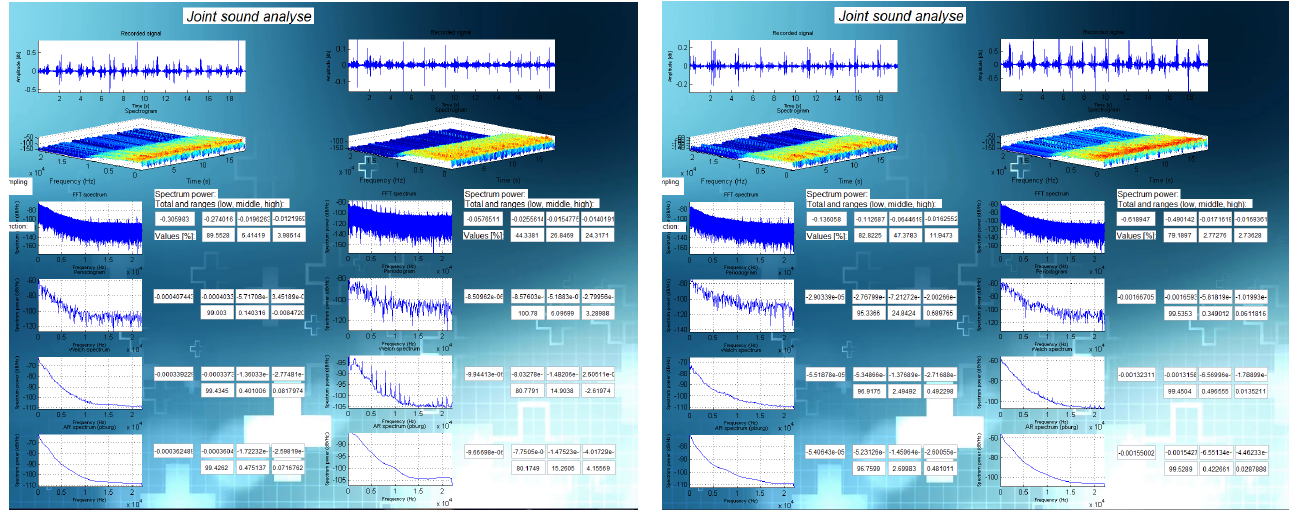
Figure A3. Analysis for subject